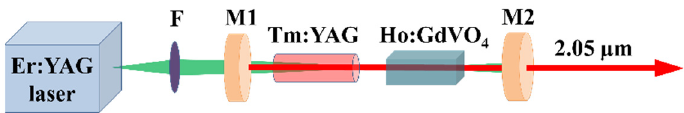
Figure 2. Experimental setup of the Tm:YAG ‐ Ho:GdVO 4 laser.